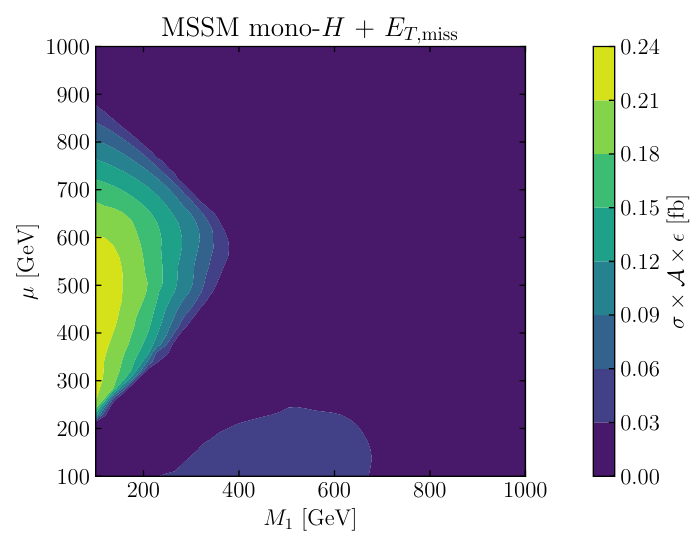
Figure 19. Predicted cross section × acceptance × efficiency for the mono-Higgs plus E miss signature in the ( M 1 , µ ) parameter plane of the MSSM according to the analysis carried out in ref.